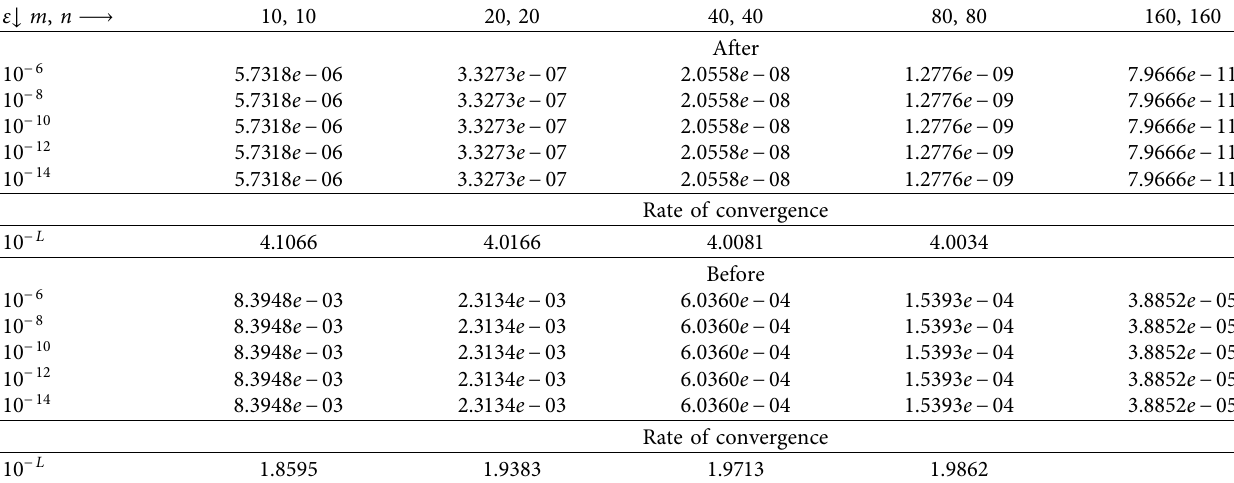
Table 1: Maximum absolute pointwise error and rate of convergence for Example 1 before and after the Richardson extrapolation method applied, where L ≥